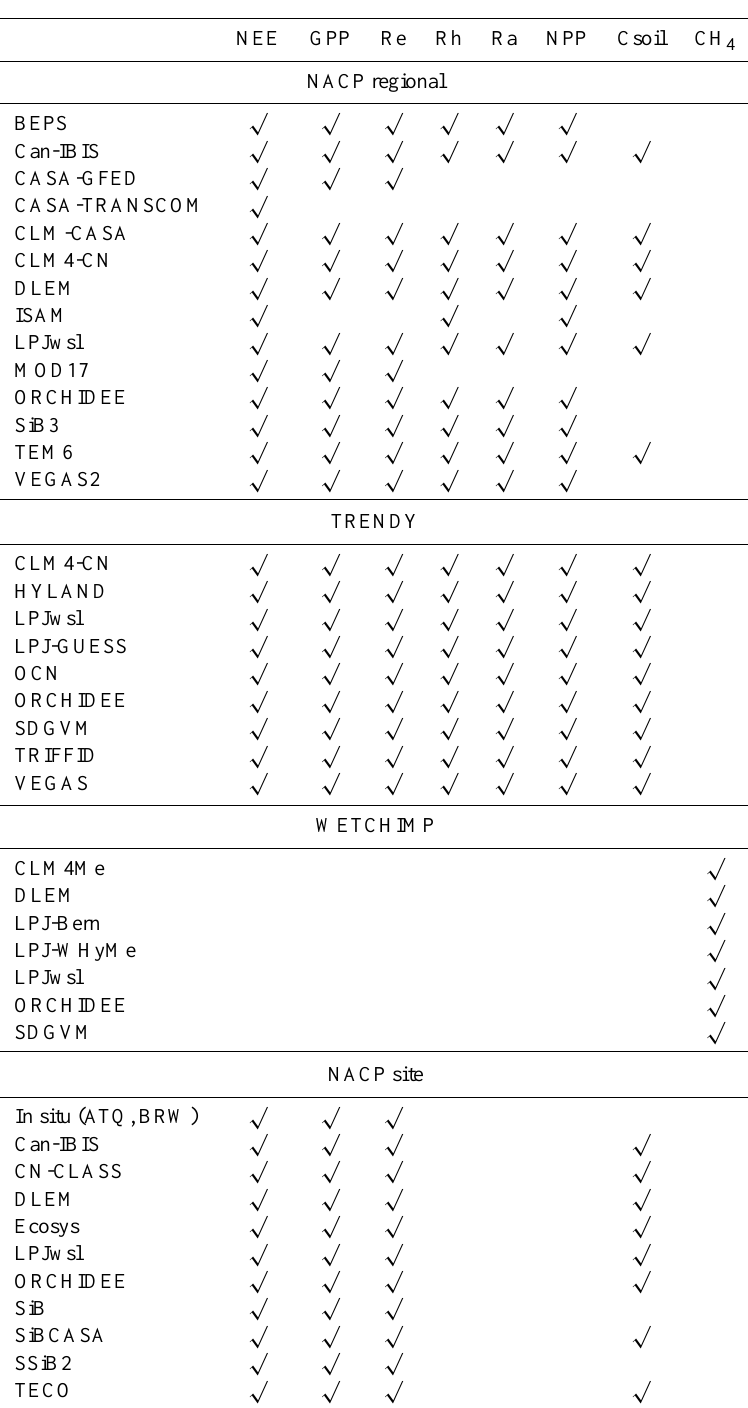
Table 1. Models and carbon output